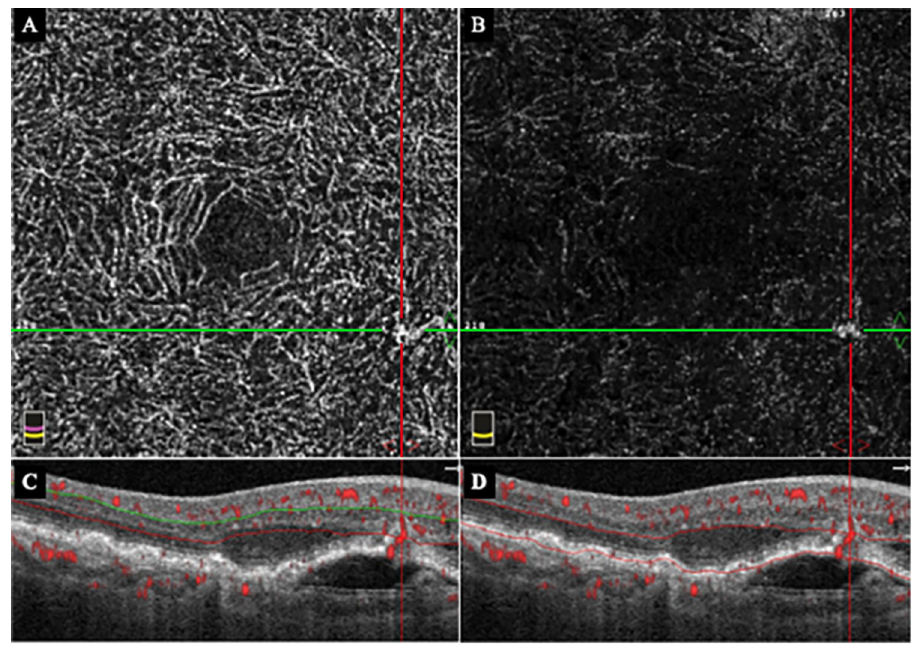
Fig 3. OCTA and OCT B scan images of the DCP and OR segments at the onset of type 3 MNV of the fellow right eye of the same case shown in Fig 1. A: En face OCTA image of the DCP of the right eye showing abnormal blood flow pattern in the inferior-nasal area of the macula where the horizontal green and vertical red lines cross. B: En face OCTA image of the OR segment showing blood flow pattern of the same area shown in A. C: B scan OCTA image of the DCP segment overlayed with blood information shows the abnormal blood pattern with retinal edema and PED. D: B scan OCTA image of the OR segment overlayed with blood information shows abnormal blood pattern with retinal edema and